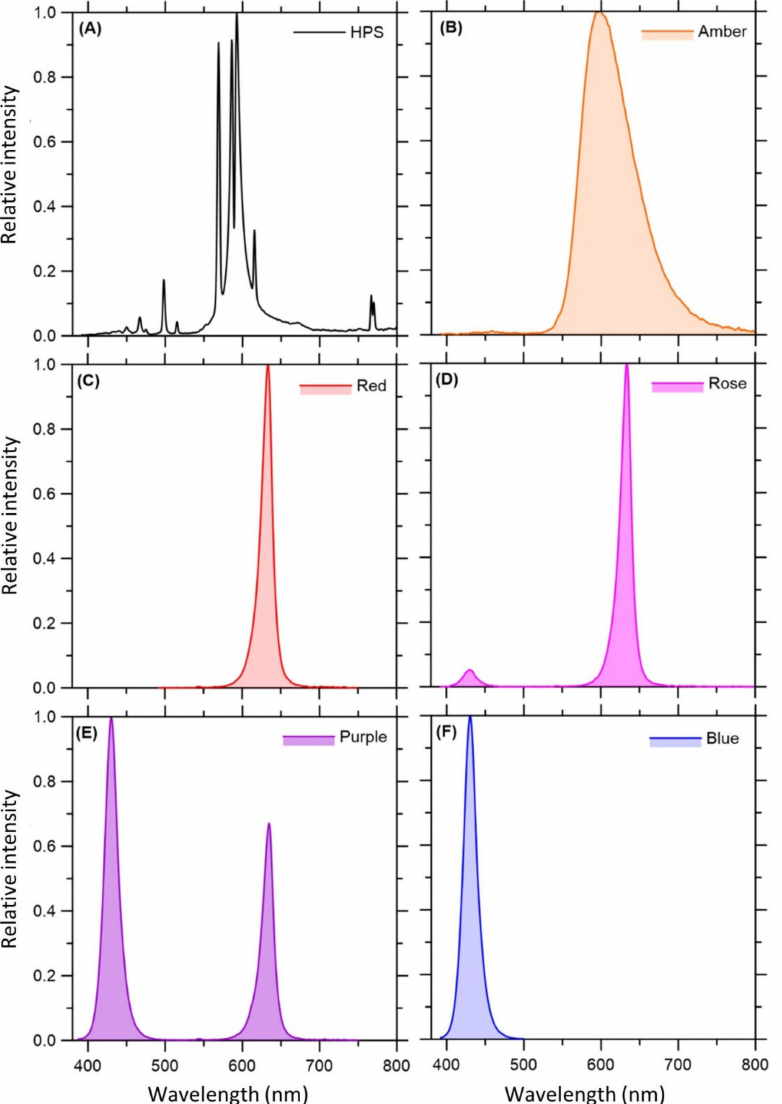
Figure 1. Relative spectra of an HPS lamp (control) and five experimental LED light treatments for cannabis plant cultivation. ( A ) HPS, ( B ) Amber (wide spectrum 595 nm), ( C ) Red (narrow spectrum 630 nm), ( D ) Rose (narrow spectrum 430 nm and 630 nm with a B:R ratio of 1:10), ( E ) Purple (narrow spectrum 430 and 630 nm spectrum with a B:R ratio of 2:1), and ( F ) Blue (narrow spectrum 430 nm) treatments. HPS: High-pressure